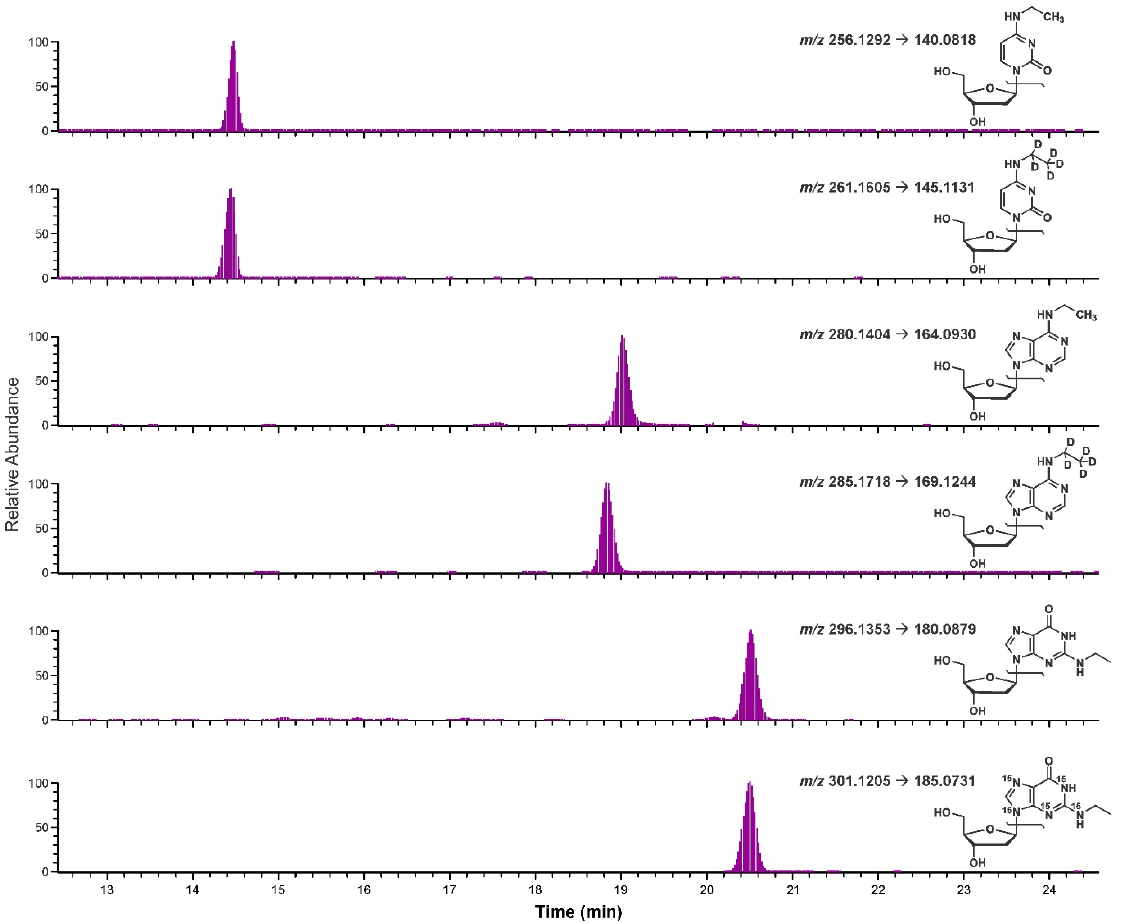
Figure 3. Chromatograms resulting from co-injection of standards with the CT-DNA sample exposed to 5 mmol ac- etaldehyde. From the top, N 4 -ethyl-dC ( m / z 256.1292), [D 5 ] N 4 -ethyl-dC ( m / z 261.1605), N 6 -ethyl-dA ( m / z